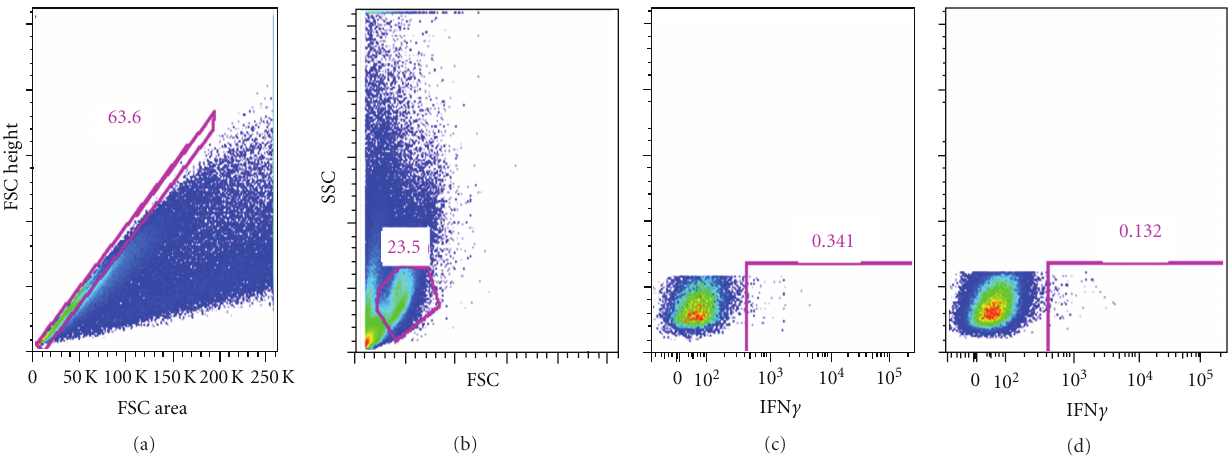
Figure 1: Flow cytometry dot plots showing gamma interferon production from the total sputum lymphocyte population. (a) shows exclusion of doublets by gating cells with proportional forward scatter area ( x -axis) against forward scatter height ( y -axis). (b) shows gating of total lymphocytes according to forward scatter ( x -axis) and side scatter ( y -axis). (c) shows the gamma interferon produced from total lymphocytes after stimulation with PPD. The position of the gate was determined in the unstimulated control tube (d) and copied into the antigen stimulated